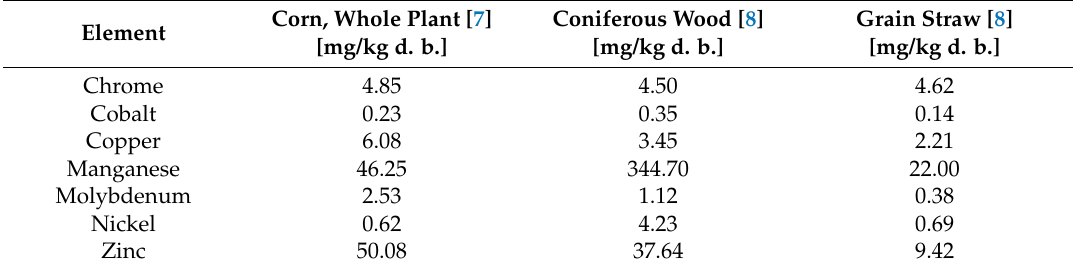
Table 1. Heavy metal contents of wood, corn stover, and corncob ash (WCSA) compared to the published heavy metal data of coniferous wood and crop of grain